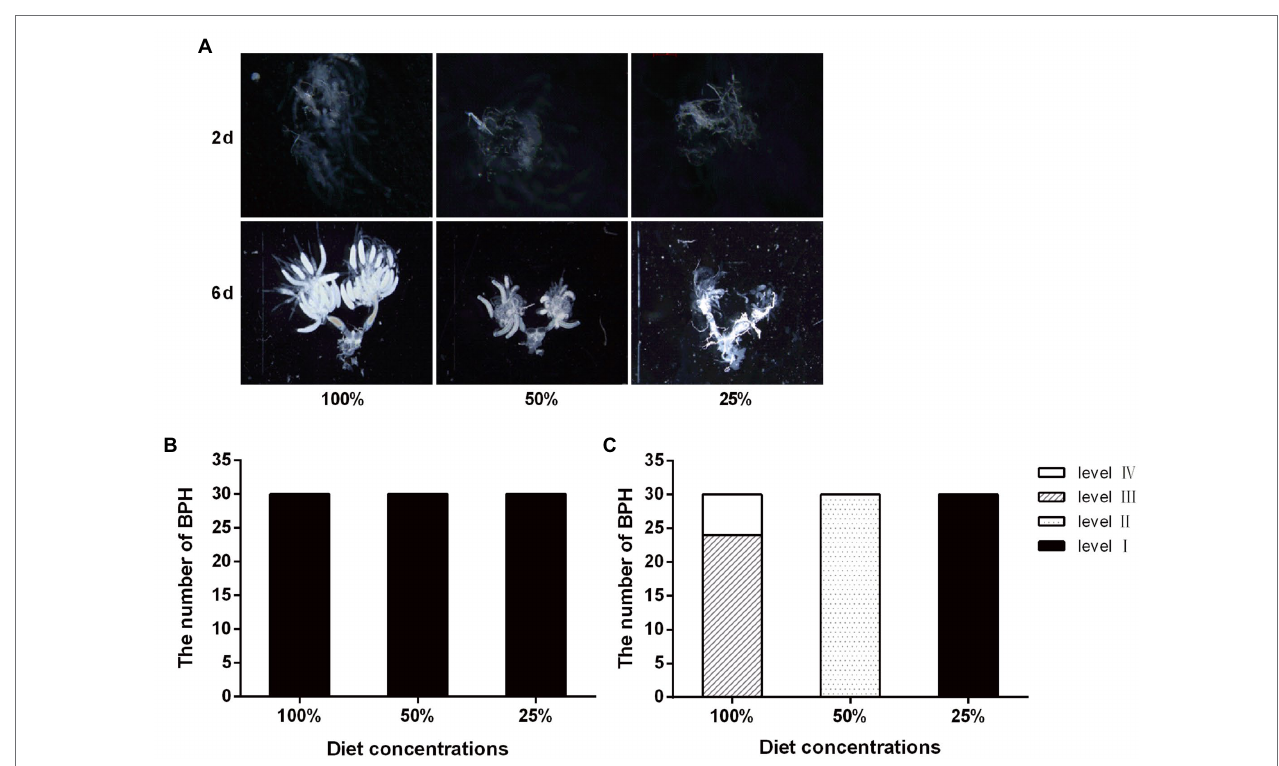
FIGURE 3 | Effect of nutrient concentration on the ovary development of the BPH. (A) Ovaries of adults fed with different concentration diet for 2 day of adult (2d) and 6 day of adult (6d); (B) Ovarian grading of BPH on 2 day of adult; and (C) Ovarian grading of BPH on 6 day of